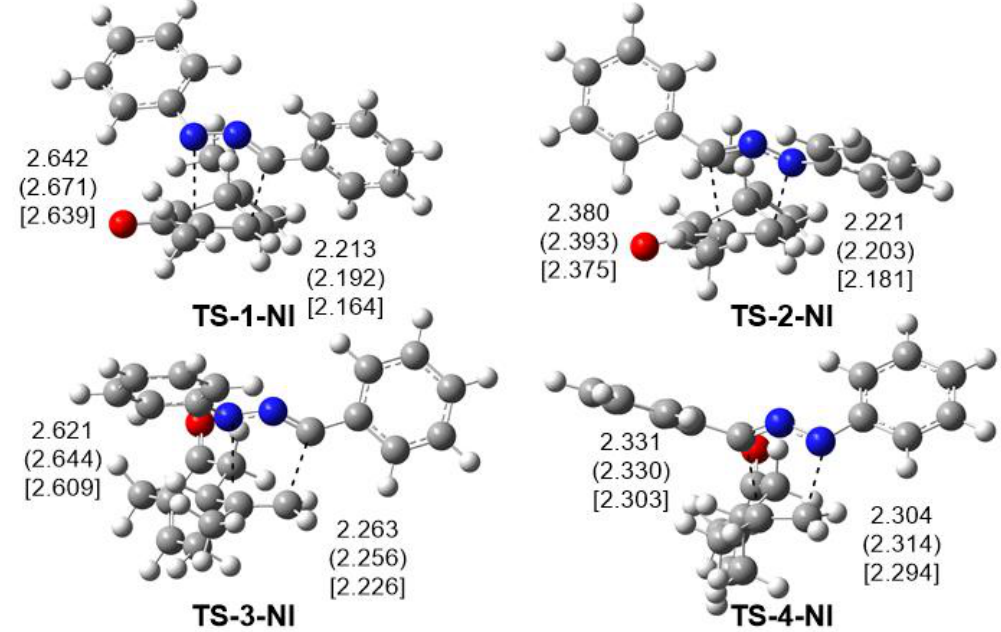
Figure 2. B3LYP / 6-31G(d) optimised geometries, in the gas phase and in dichloromethane (DCM), of the transition state structures (TSs) involved in the 32CA reaction of diphenyl NI 2a with (R)-carvone 1 . Distances are given in angstroms, Å. Values in DCM are given in parentheses, while the B3LYP / 6-311G(d,p) values in DCM are given in brackets.